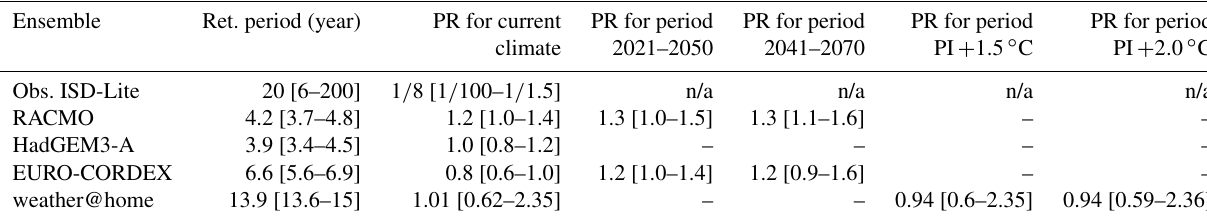
Table 3. Event return periods and probability ratios summarized for all model ensembles and for storm Eleanor. PI is pre-industrial and n/a is not applicable.